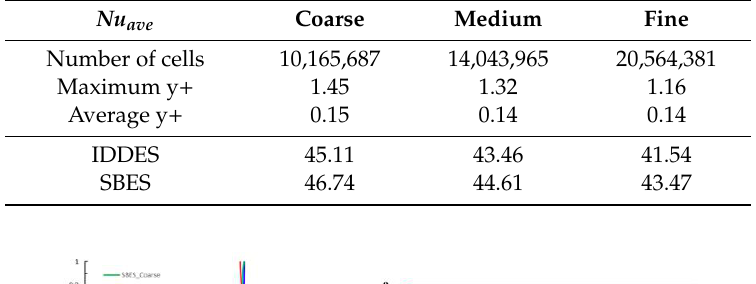
Table 1. Grid independence test.